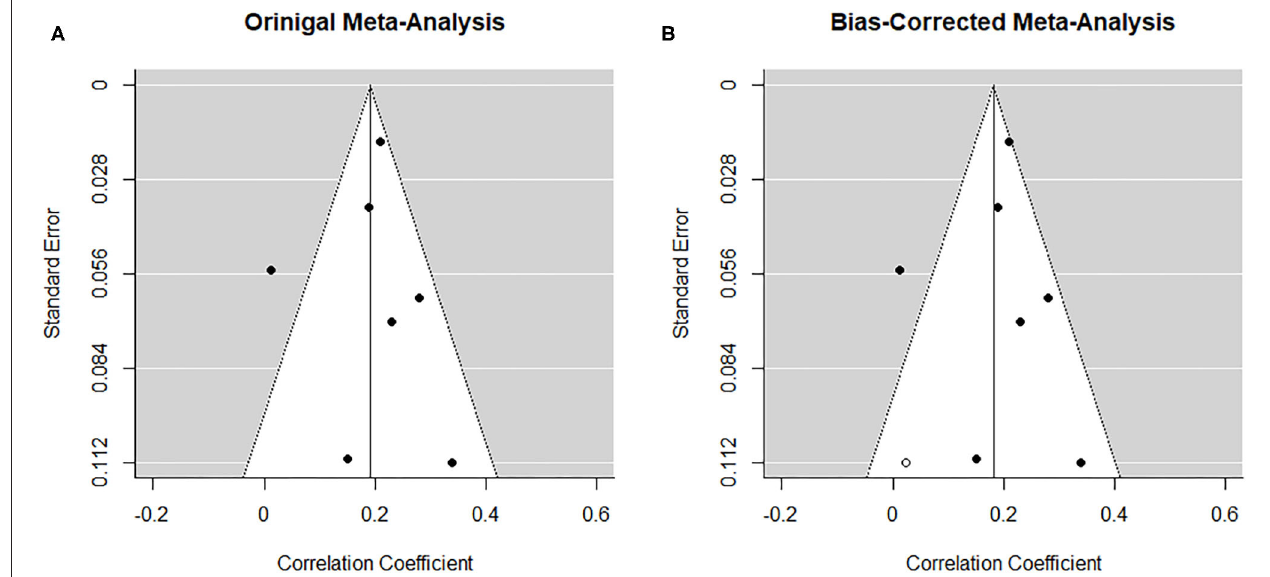
FIGURE 7 | Funnel plots before (A) and after (B) applying trim-and-fill method corresponding to the prospective association between paternal depression at one timepoint and maternal depression at a later timepoint during the perinatal period. The open dots indicate imputed studies.